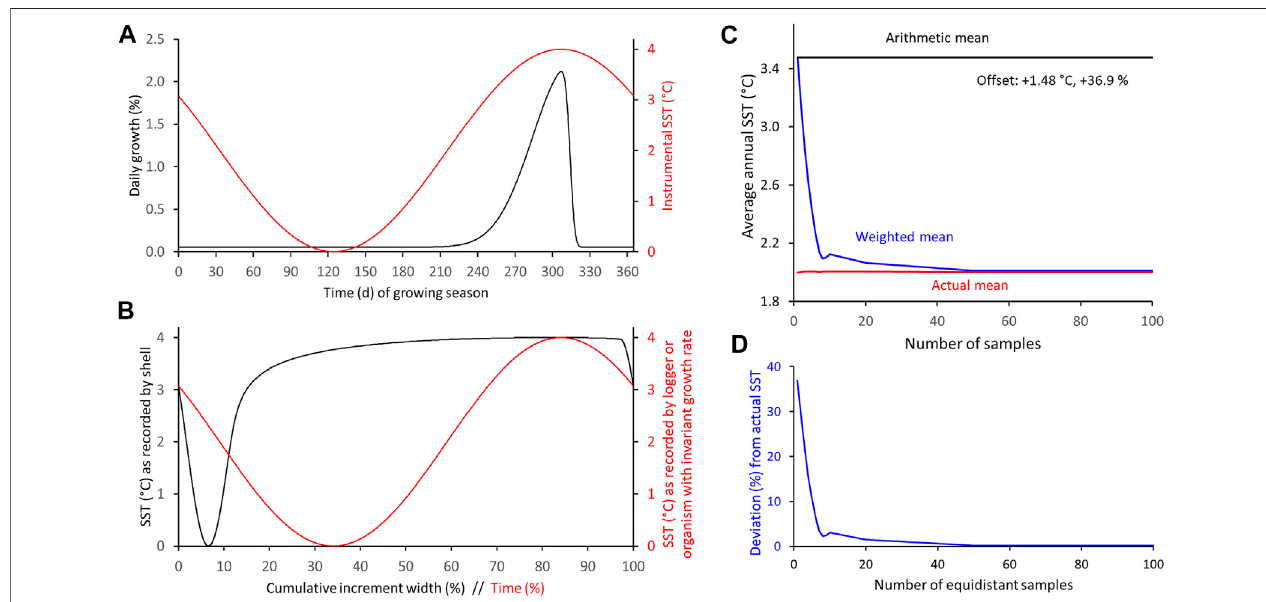
FIGURE 9 | Numerical simulation of differences between arithmetic and weighted annual means computed from intra-annual proxy-SST assuming main growing season (fast growth) is limited to about 3 months, shell growth and SST curves are in phase, growth curve is left-skewed and SST curve has a symmetrical shape. (A) Modeled seasonal shell growth and SST. (B) SSTasrecorded by modelshelland logger. (C,D) Arithmetic and weighted annual proxy-SST incomparison toactual SST mean. With increasing sample resolution, the weighted mean agrees better with the instrumental SST average (C) : absolute values; (D) : relative values.